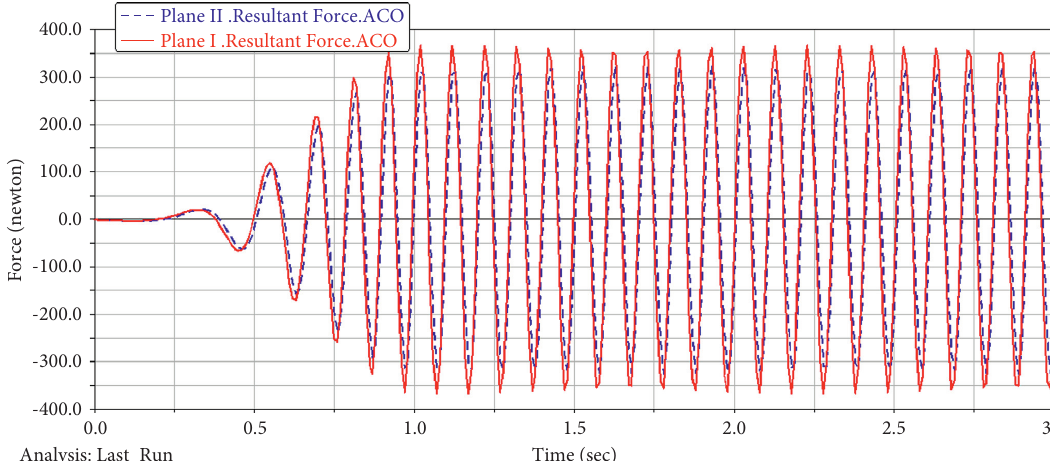
Figure 9: Simulation results of ACO in ADAMS.